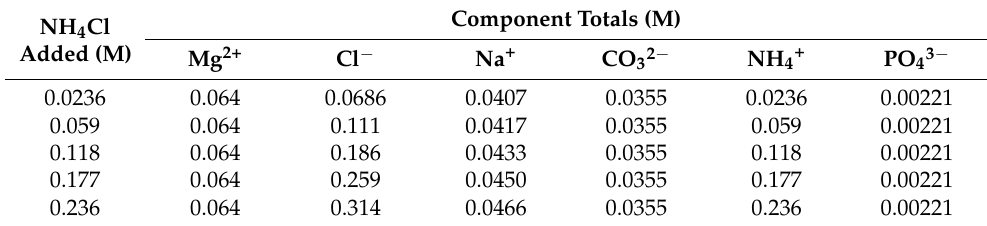
Table A2. MINEQL+ component totals for Mg char at pH 8.